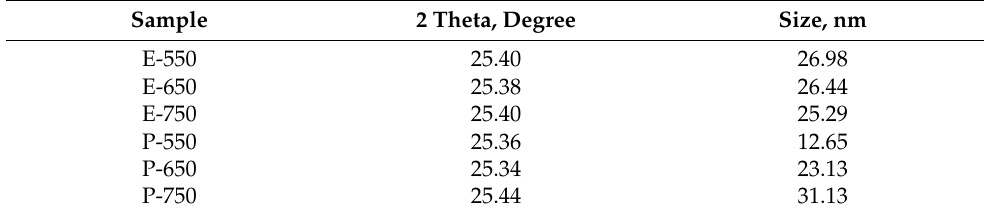
Table 3. Particle sizes calculated from XRD patterns.